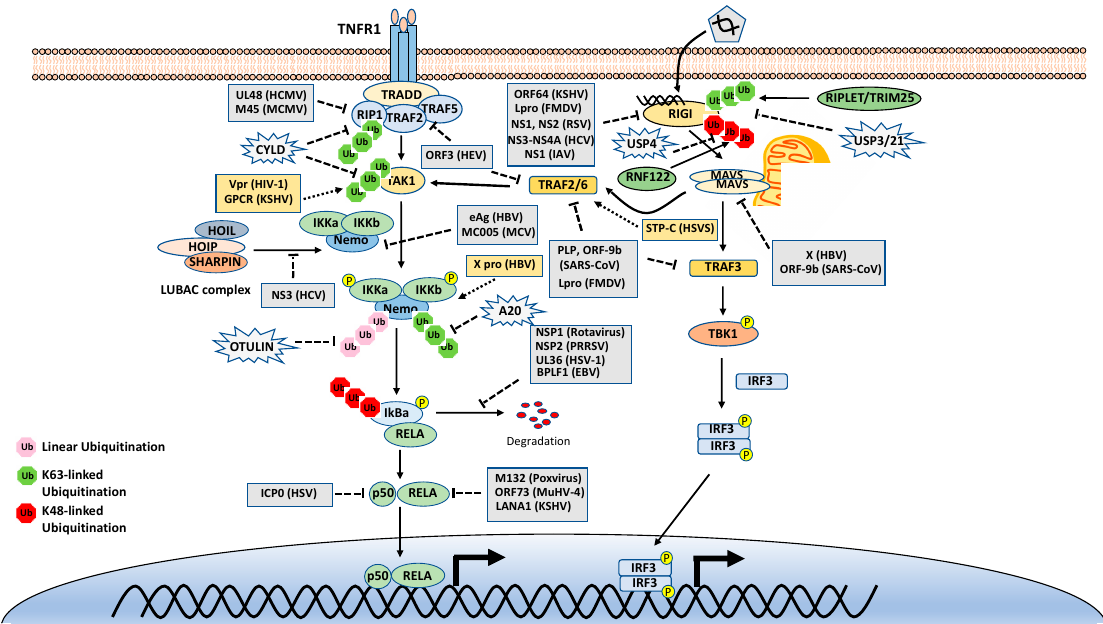
Figure 3. Tumor necrosis factor receptor type 1 (TNFR1) and retinoic acid-inducible gene I (RIG-I) signaling pathways. K48-, K63-, and Met1-linked polyubiquitinations are illustrated. Virus proteins that suppress or activate NF- κ B via modulation of ubiquitination are indicated.